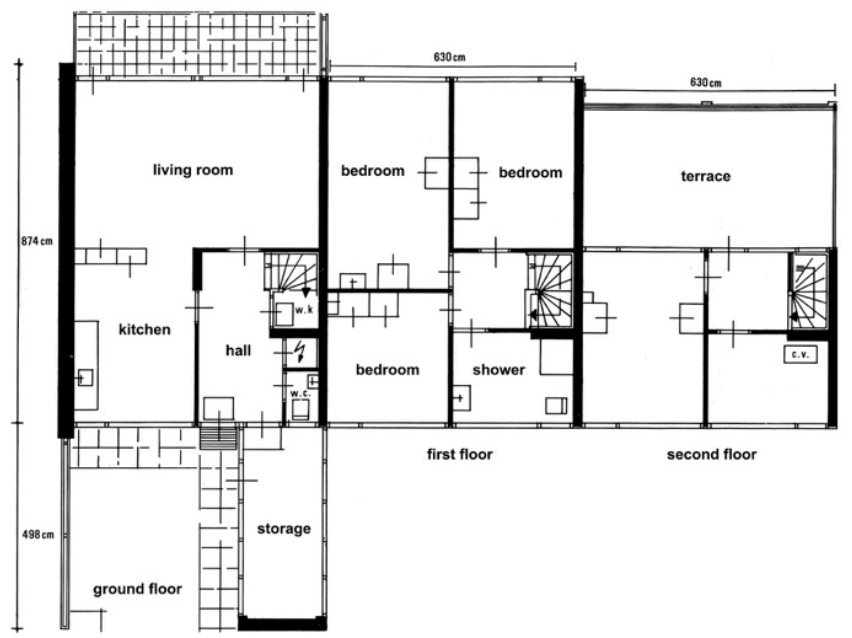
Figure 9. Zuiderzeewijk’s piano house’s floor plans. Source: Flevolands archive.